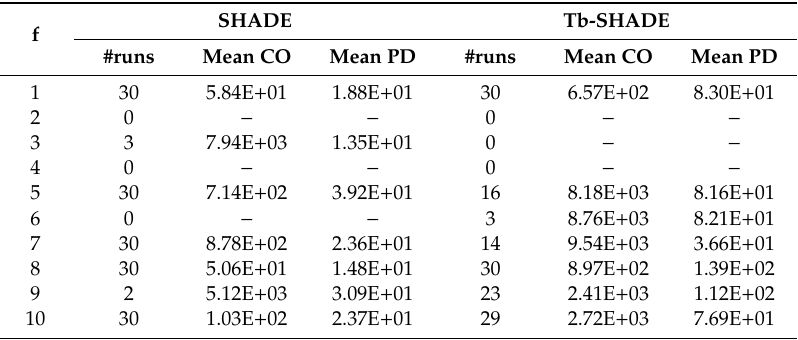
Table 24. Clustering and population diversity of SHADE and Tb-SHADE on the CEC2020 in 10 D .